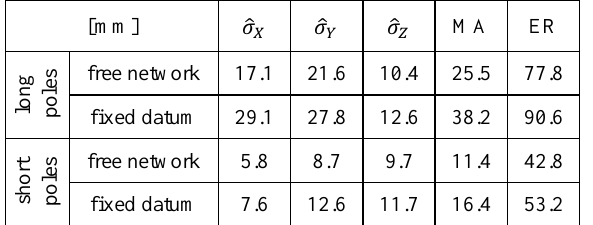
Tab.3: Summary of geodetic network adjustment results for long- and short pole configurations with fixed datum and free network. Given are the average values obtained for the estimated a posteriori 𝜎̂ for each coordinate component, the length of the major semi-axis of the error ellipsoids (MA), and the external reliability